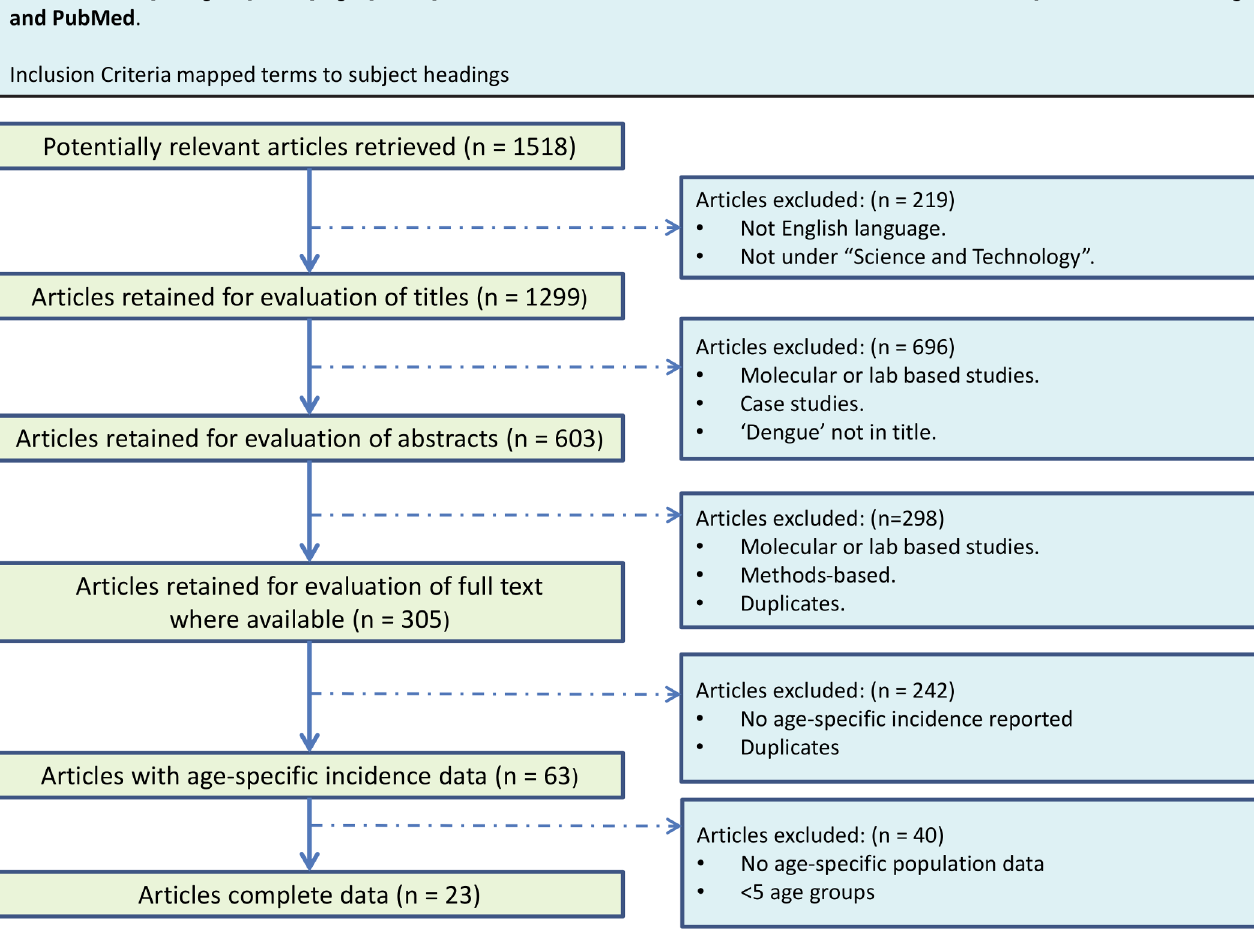
Fig 1. Flowchart describing the literature search process for age-stratified incidence